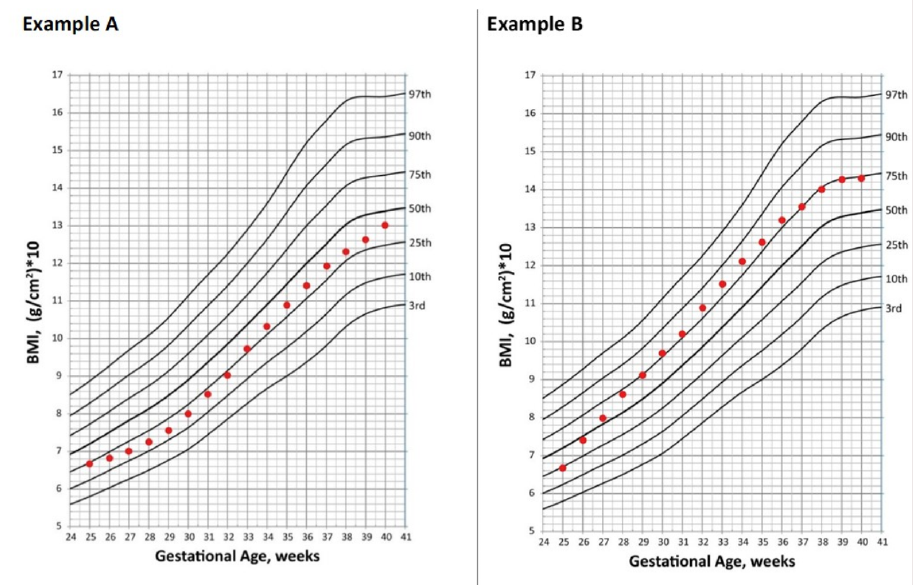
Figure 5. Comparison of body mass index trend from 25–40 weeks gestation in an extremely low birth weight infant with adequate (Example A ) vs. early growth failure (Example B ) for linear growth when weight gain is adequate. Examples A and B modified and reproduced with permission from first author Irene Olsen, published in Pediatrics , Vol. 135, page 575, Copyright © 2015 by the American Academy of Pediatrics. Original article published as “BMI Curves for Preterm Infants” by Olsen et al.